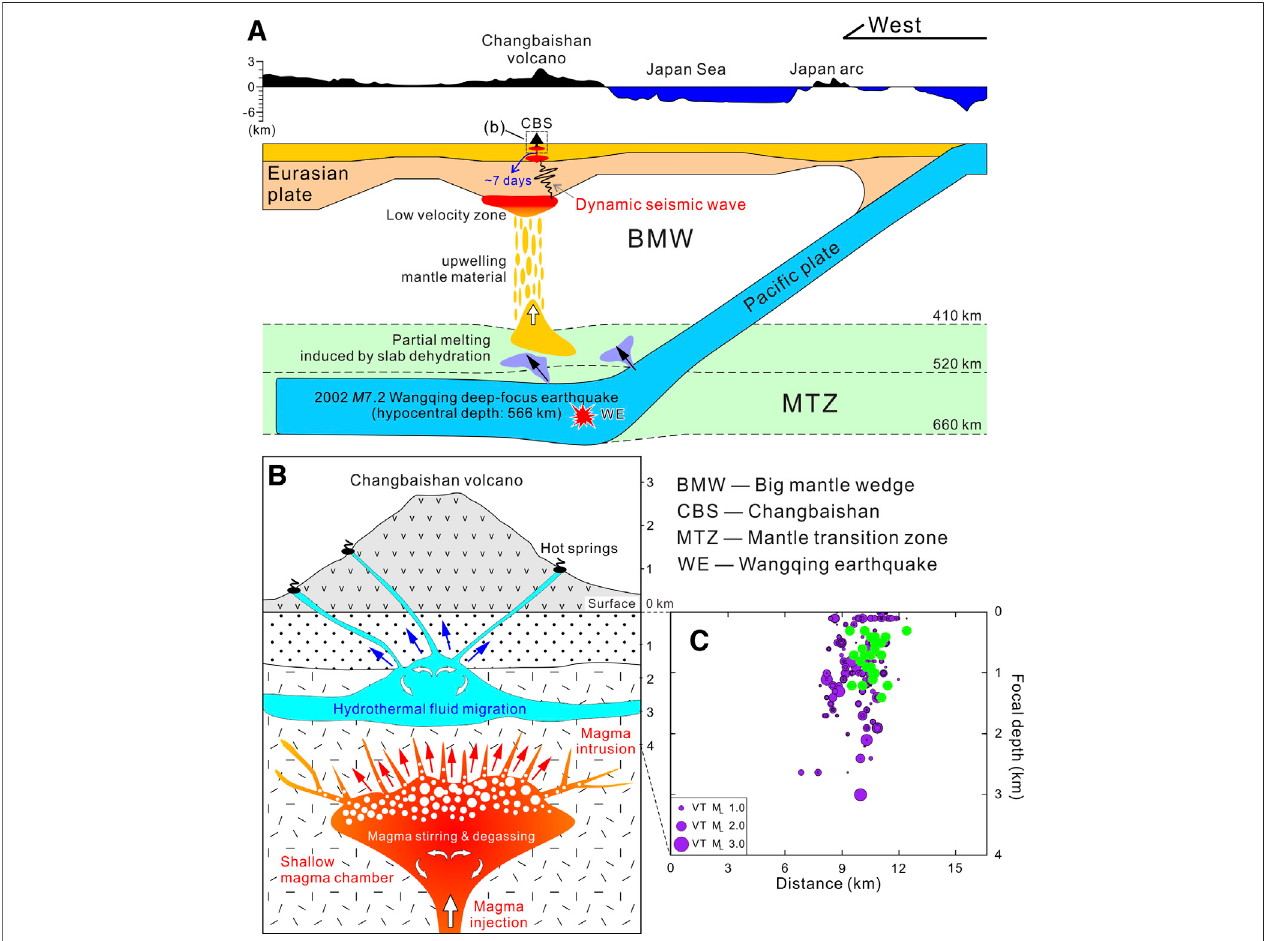
FIGURE10|(A) AconceptualmodelshowingmagmamigrationfromadeepsourcetoashallowreservoirofChangbaishanvolcanoinresponsetodynamicstress perturbationsrelated totheWangqingdeep-focusearthquakeinthestagnantPaci fi cPlatebeneath NEAsia.Anupwellingplumederivedfromthemantletransitionzone is shown as the magma origin of Changbaishan volcano based on studies of seismic tomography (Zhao et al., 2009) and basalt geochemistry (Zhang et al., 2018). The 410, 520, and 660 km discontinuities are from Tian et al. (2016). (B) Hypothetical magmatic and hydrothermal processes corresponding to the 2002 – 2005 unrest ofChangbaishan volcano.Injection ofdeep-sourced magmasintotheshallowmagmachamber ledtoanomalousmagmastirringanddegassing,whichpressurized the shallow magma chamber and facilitated intrusion of gas-enriched magmas through cracks above the magma body. Hydrothermal fl uid migration was in fl uenced by crack intrusion of magmas. (C) A cross-sectional view of the study region along AB in Figure 1B . The green circles indicate HS events, and the purple circles with different scales indicate VT events with different magnitudes.